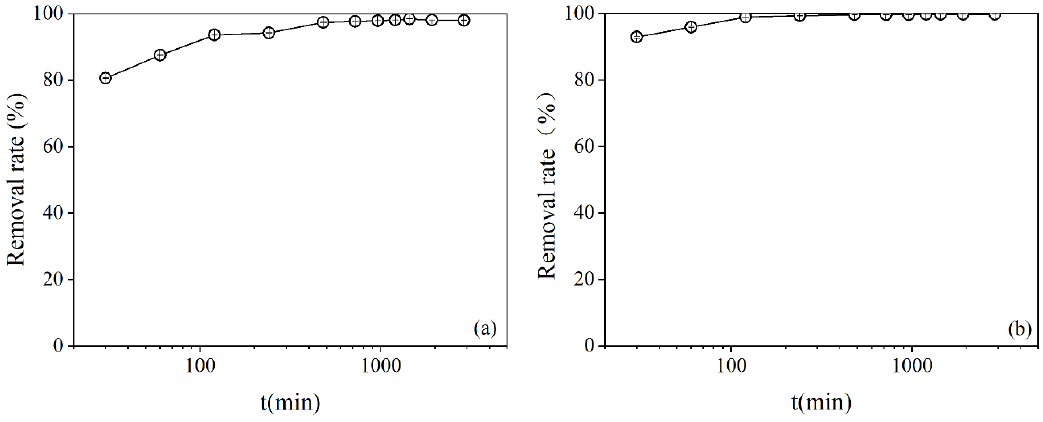
Figure 3. Adsorption kinetics in the HTSS ( a ) and control solution ( b ).